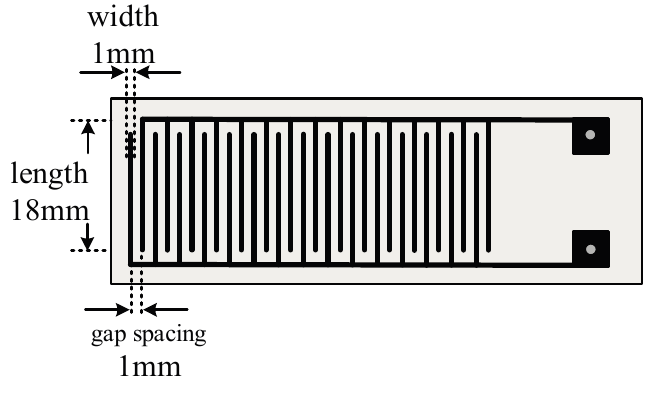
Figure 4. Diagram of the interdigital electrode